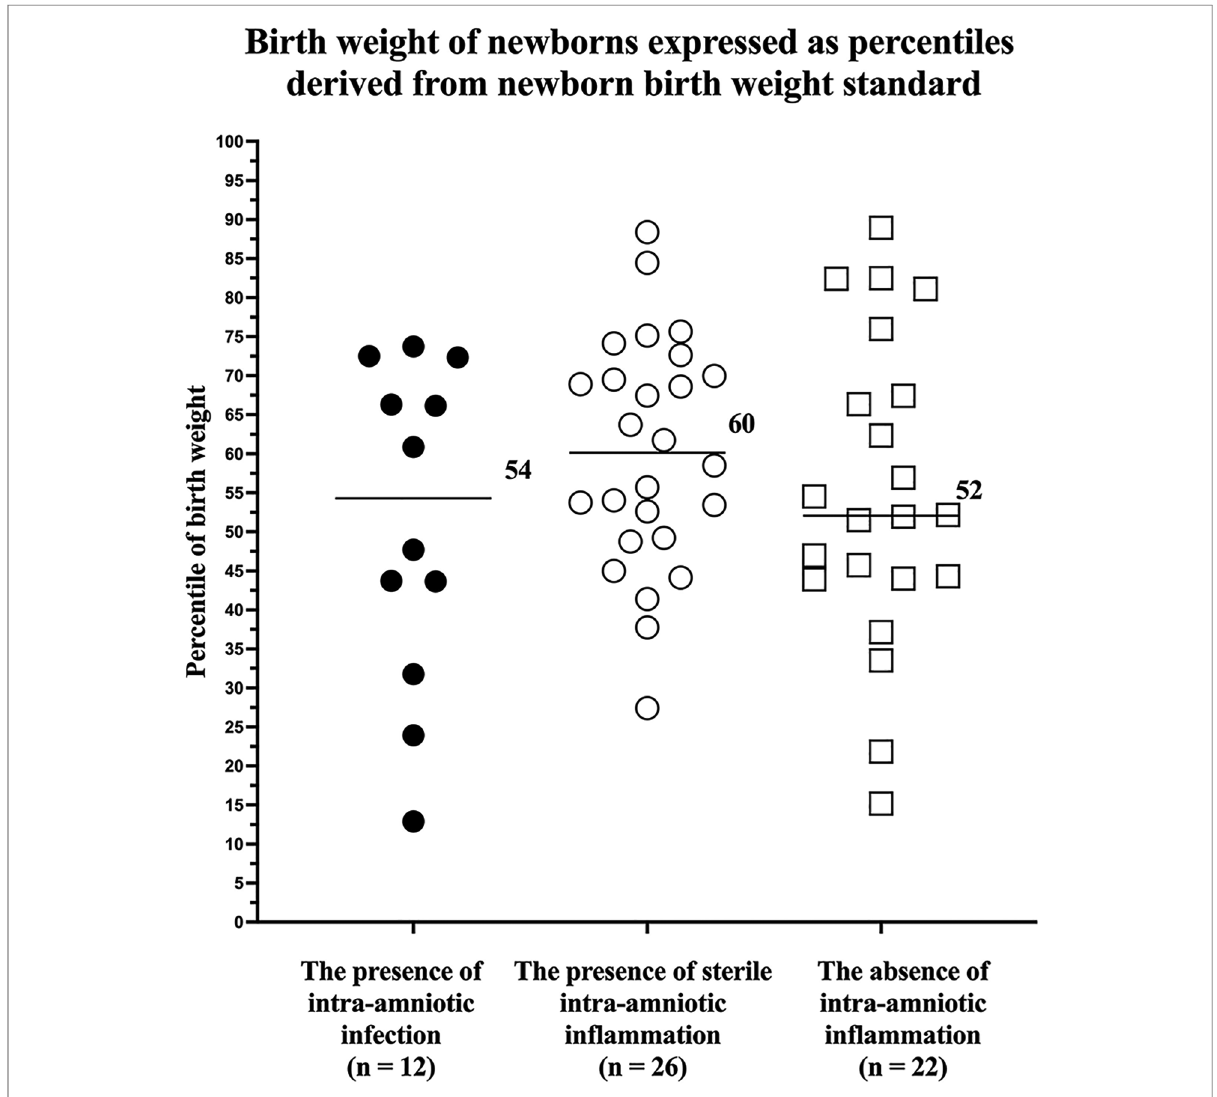
FIGURE 2 Comparison of newborn birth weight, expressed as percentiles derived from neonatal birth weight standards, from pregnancies with preterm labor with intact membranes prior to a gestational age of 35 weeks with the presence of intra-amniotic infection, presence of sterile intra-amniotic in fl ammation, and absence of intra-amniotic in fl ammation. Medians are